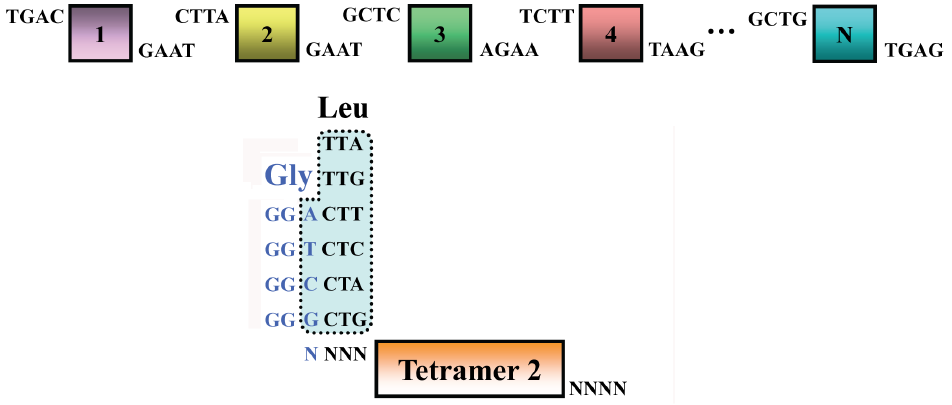
Figure 4. Optional assembly of TALE repeats depending on PCR mutation. Amplified with different primer pairs, repeat monomers, dimers, trimers or tetramers (1, 2, 3, 4 and N in this Figure) can be flexibly assembled in an optional order during a cut/ligation reaction. Some selected cohesive ends are shown and other possible cohesive ends can be designed by matching the last nucleotide coding Gly and three nucleotides coding